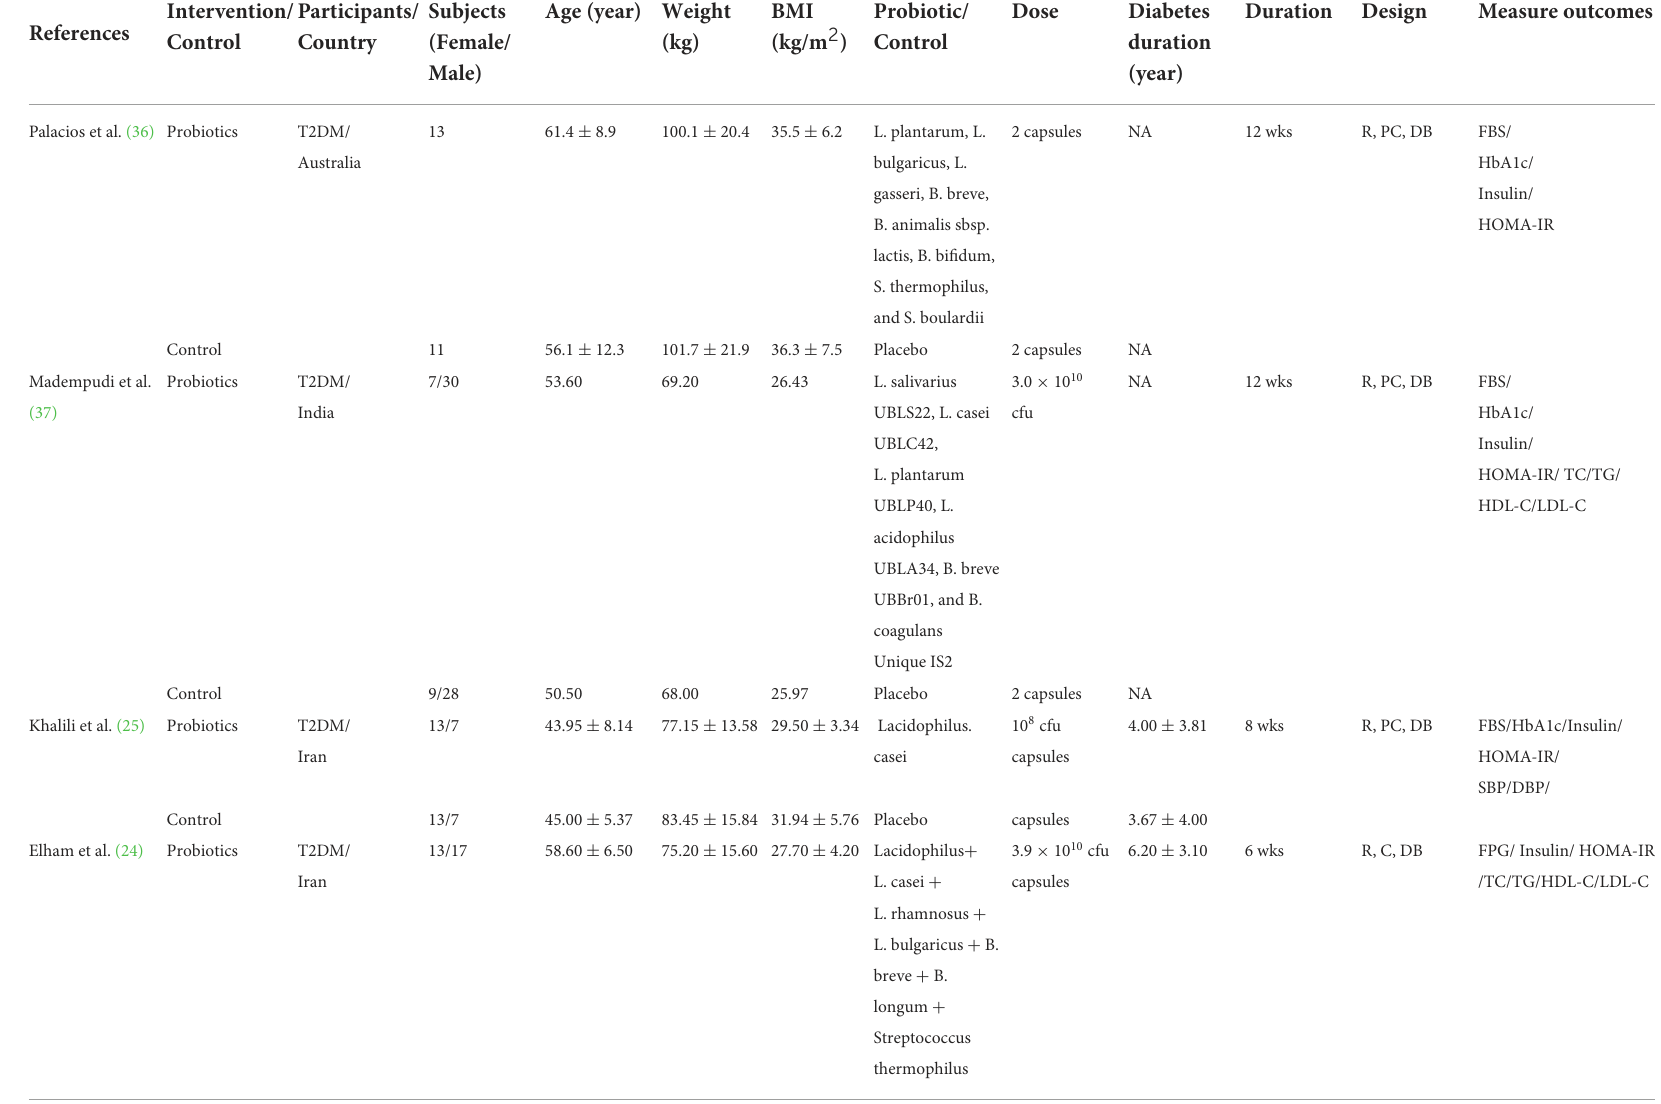
TABLE 1 Characteristics of probiotic treatment studies included in this